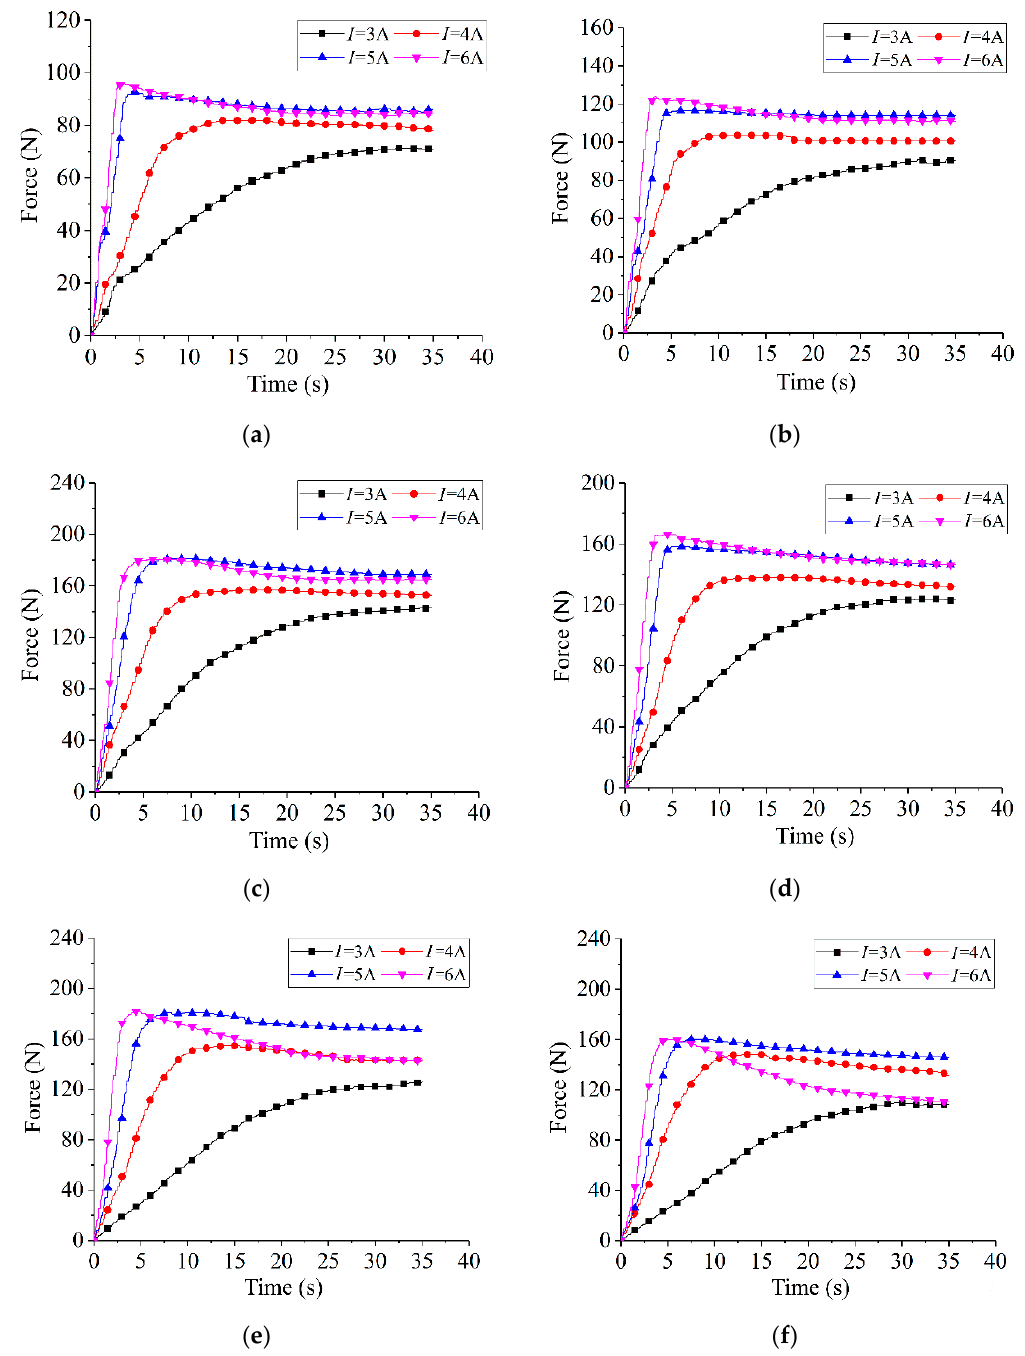
Figure 7. The restoring force of NiTi wires subjected to different electric currents: ( a ) ε = 2%; ( b ) ε = 3%; ( c ) ε = 4%; ( d ) ε = 5%; ( e ) ε = 6%; and ( f ) ε = 7%. Table 4. Maximum restoring force and required time at different electric currents.